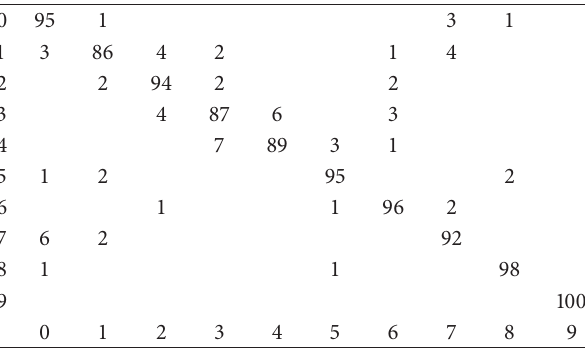
Table 4: The confusion matrix of FEMD on data set 2 (from [25]).